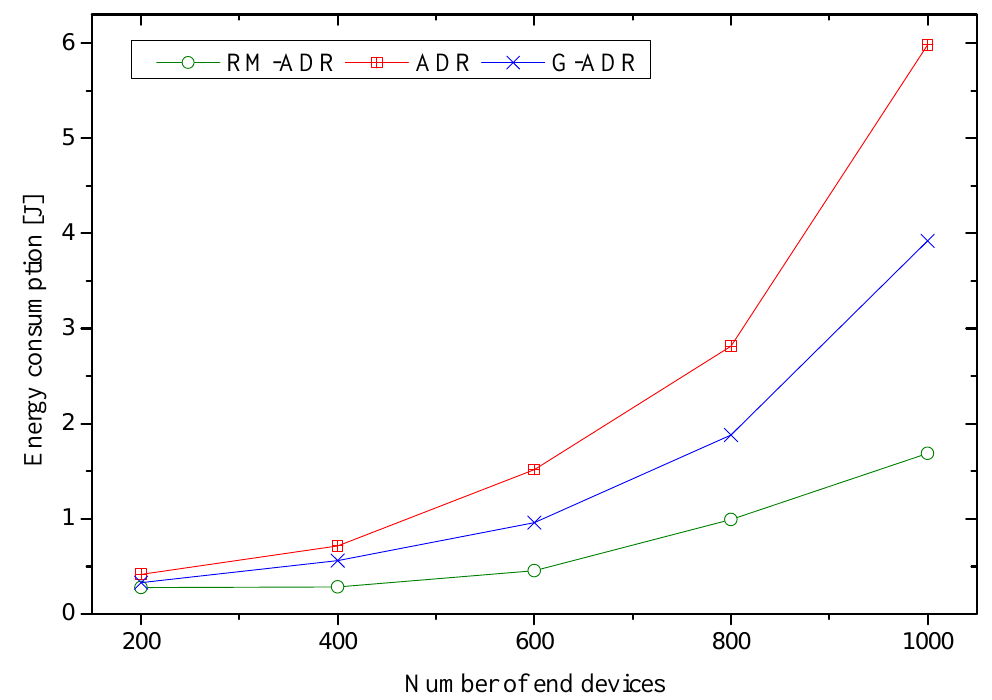
Figure 9. Energy Consumption in Joules [J] of the proposed RM-ADR and existing ADRs.